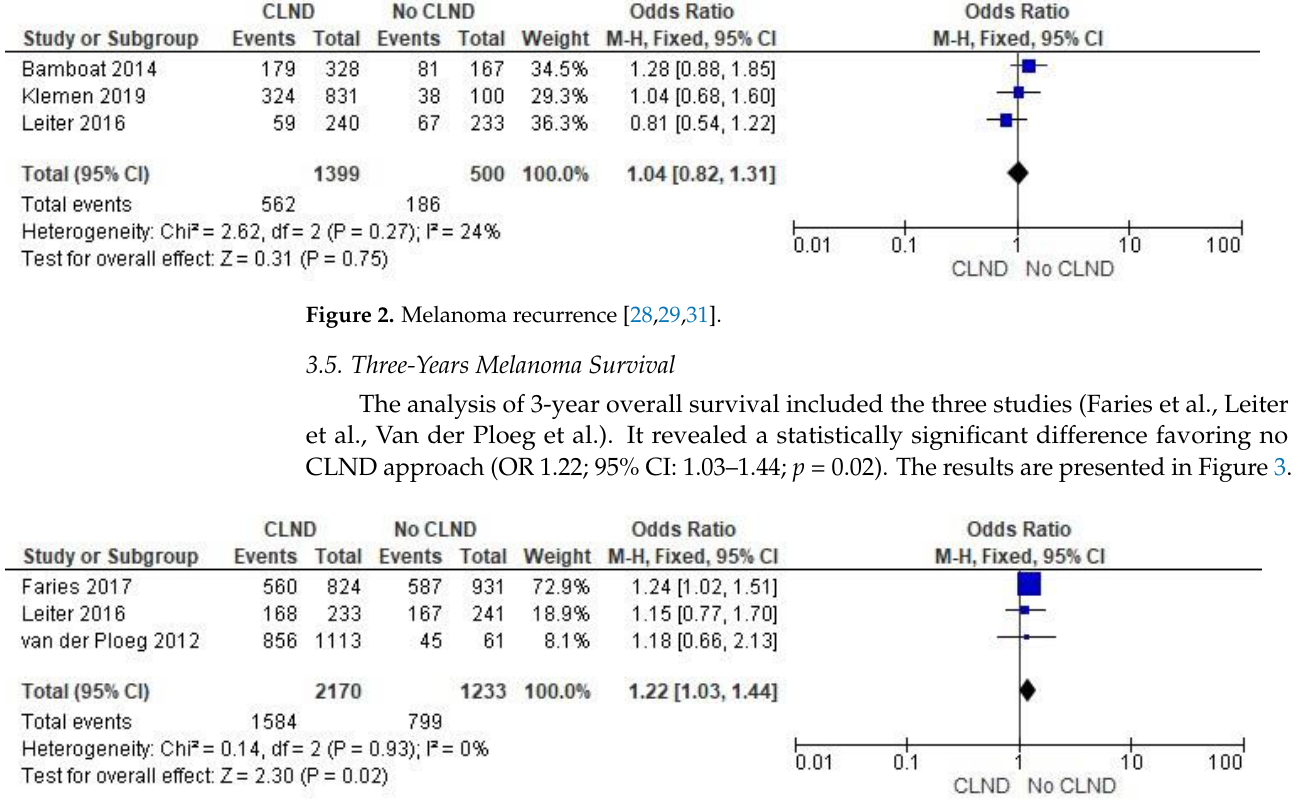
Figure 3. Three-years melanoma survival [4,31,32].